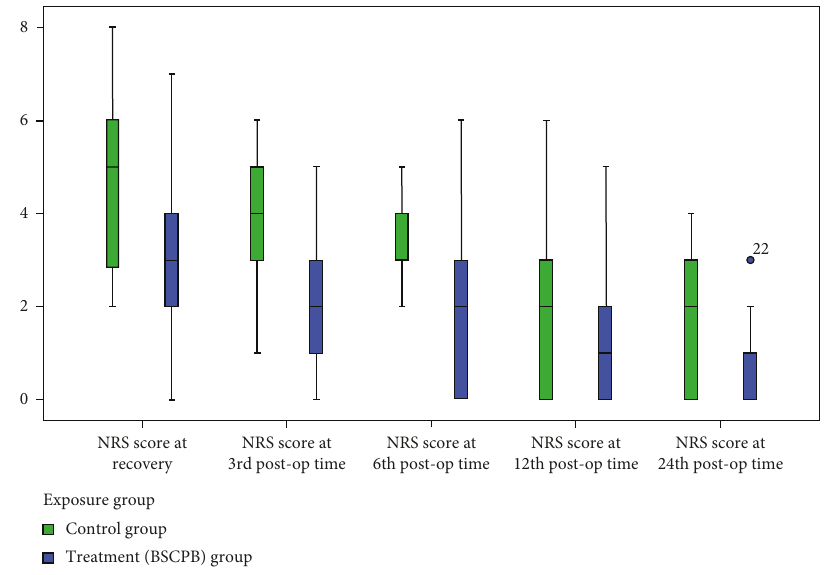
Figure 1: Comparison of postoperative pain using the 11-point NRS score (0–10). Table 4: Comparison of time to first analgesia request and total analgesia consumption between groups.